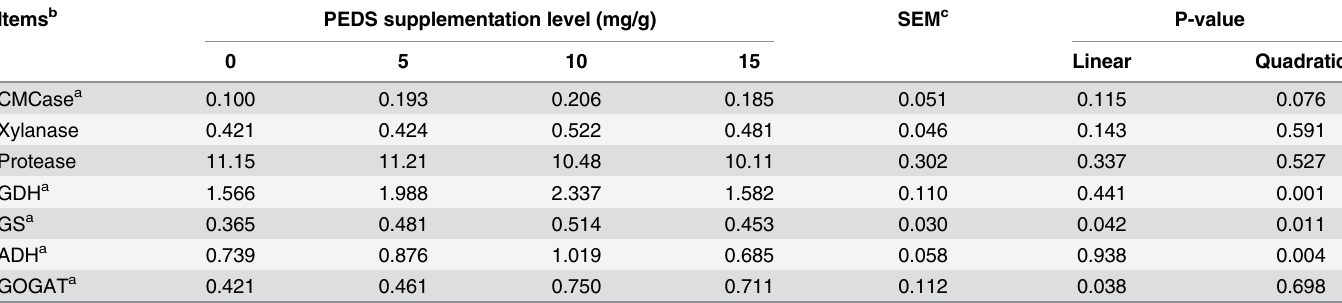
Table 3. The effects of PEDS supplementation level on the activity of enzymes in continuous culture. Items